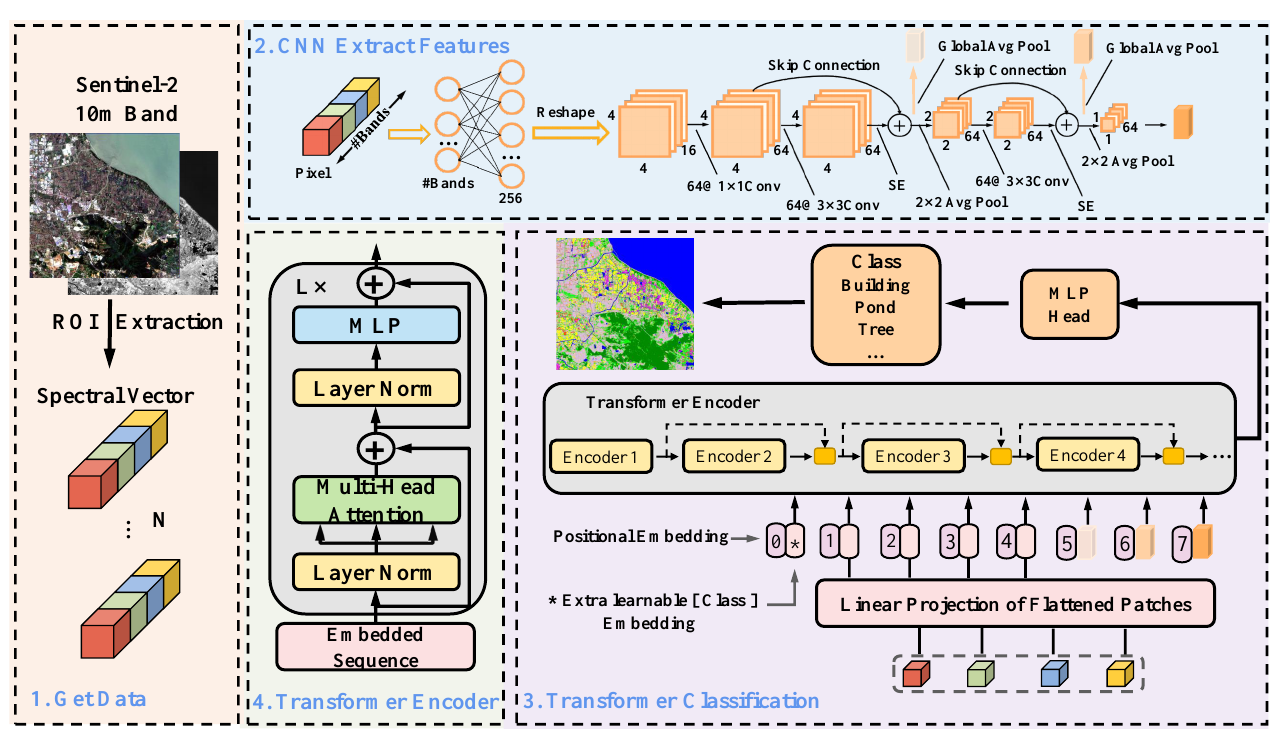
Figure 4. Schematic diagram of HyFormer architecture for the multispectral image classification task. The HyFormer consists of an FC, CNN, feature fusion module, and